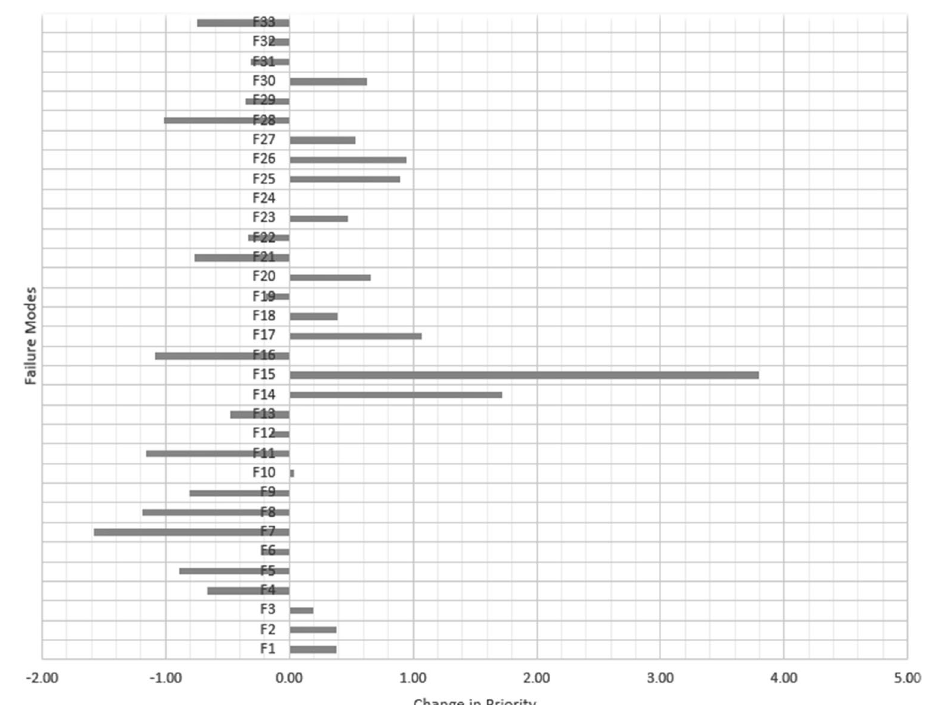
Fig. 8 Comparative chart of "RPN" change (Influence